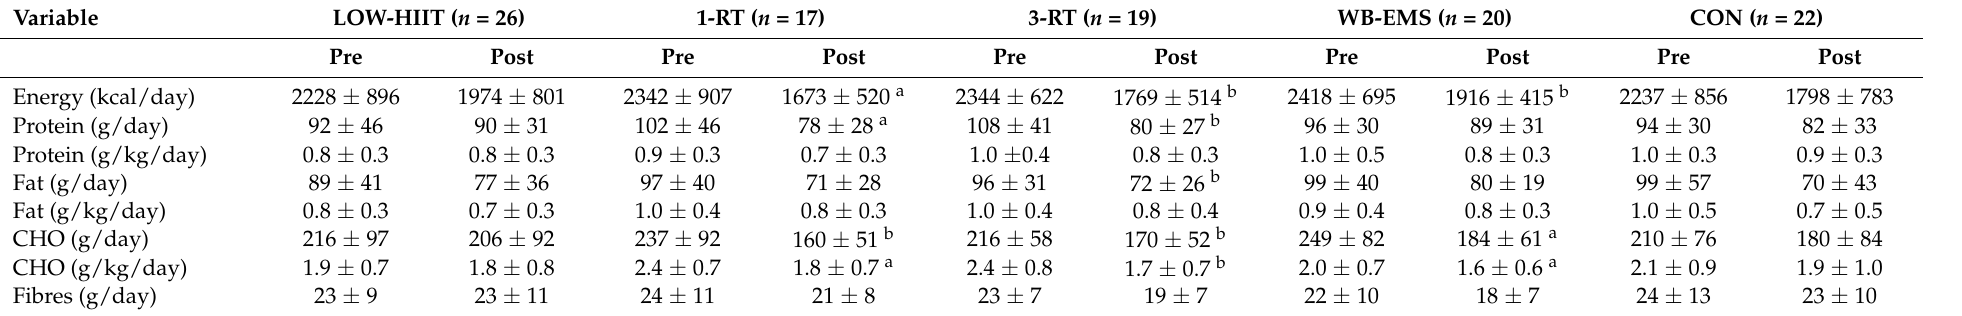
Table 2. Daily nutritional intakes before the intervention and during the last week of